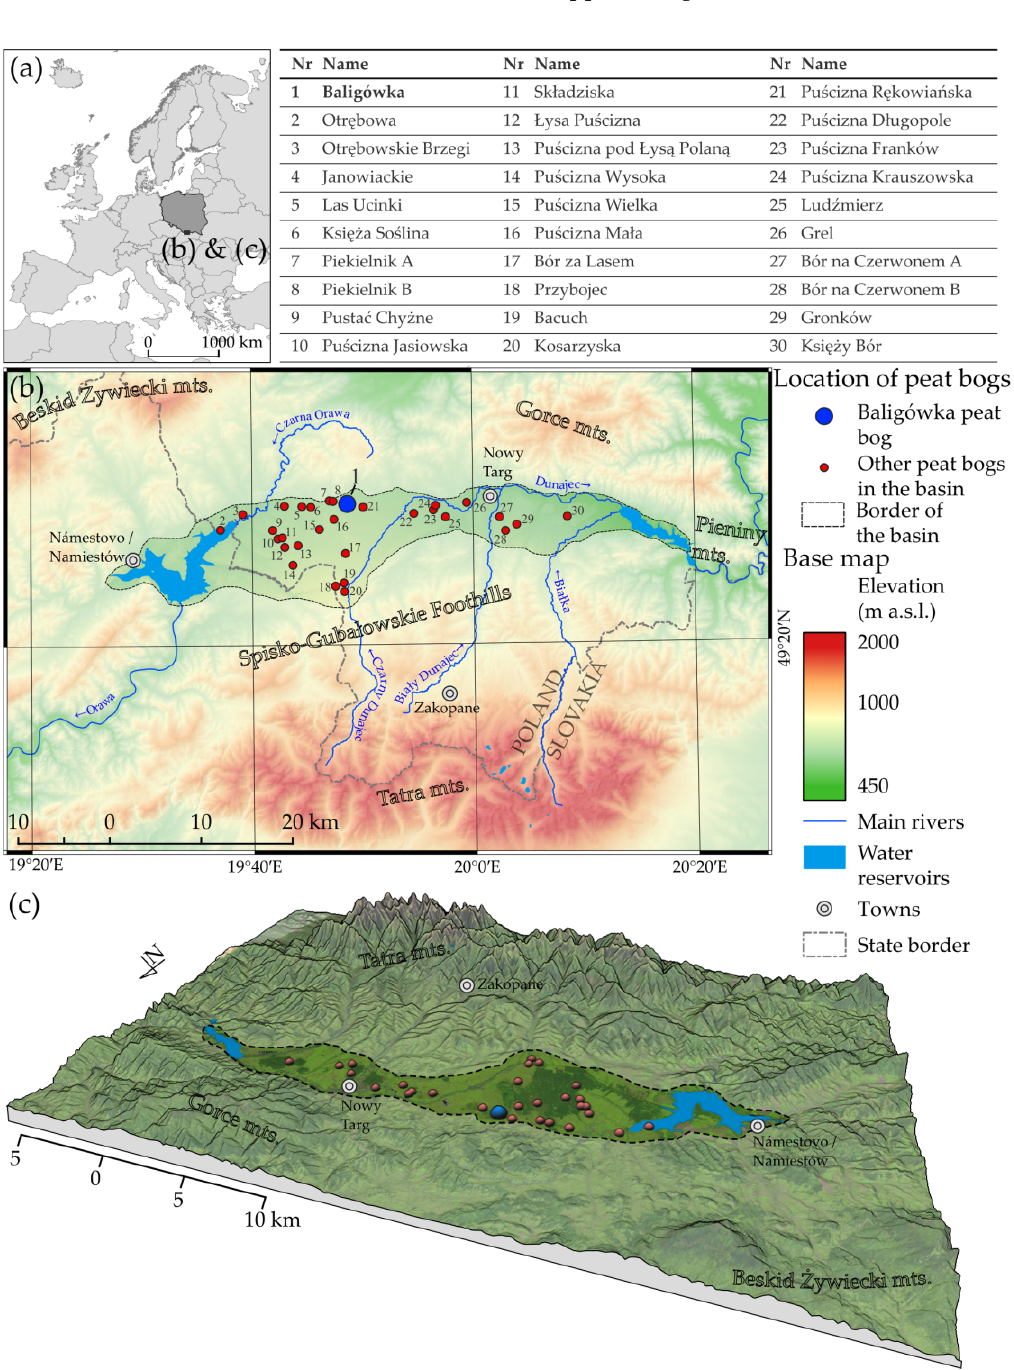
Figure 1. Location of study area: ( a ) localization of maps ( b , c ); ( b ) map of peat bogs in the Orawa-Nowy Targ Basin; ( c ) 3D model of the central part of the Polish Carpathian Mountains with location of the peat bogs.